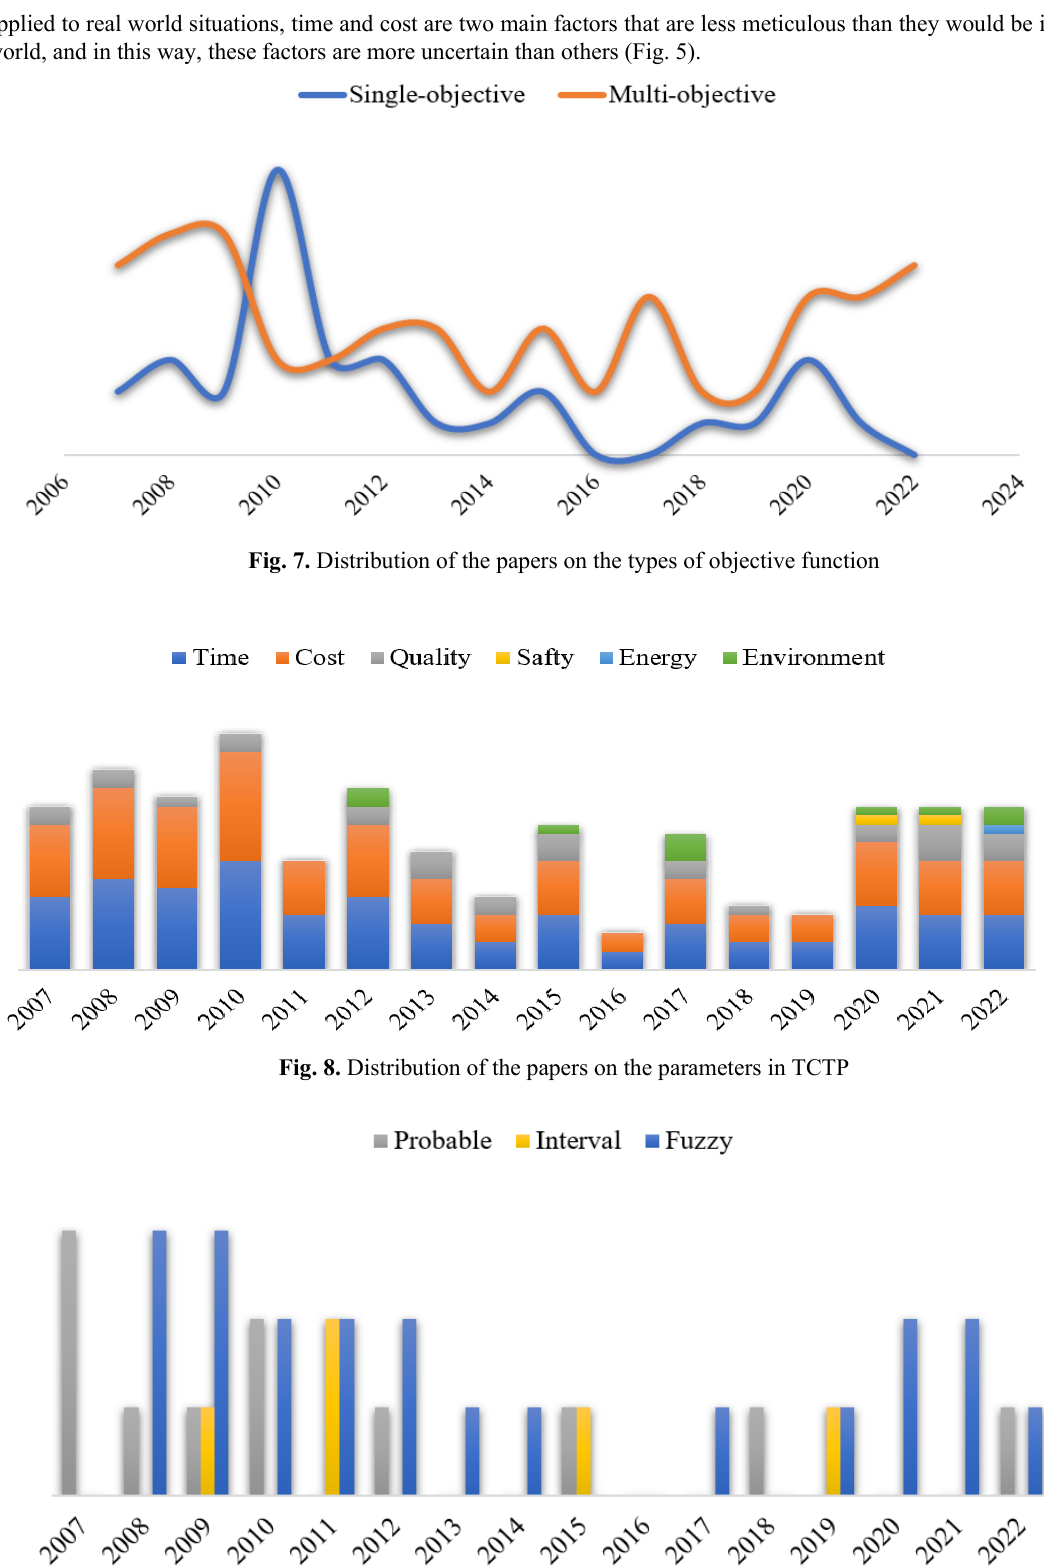
Fig. 9. Distribution of the papers on the types of